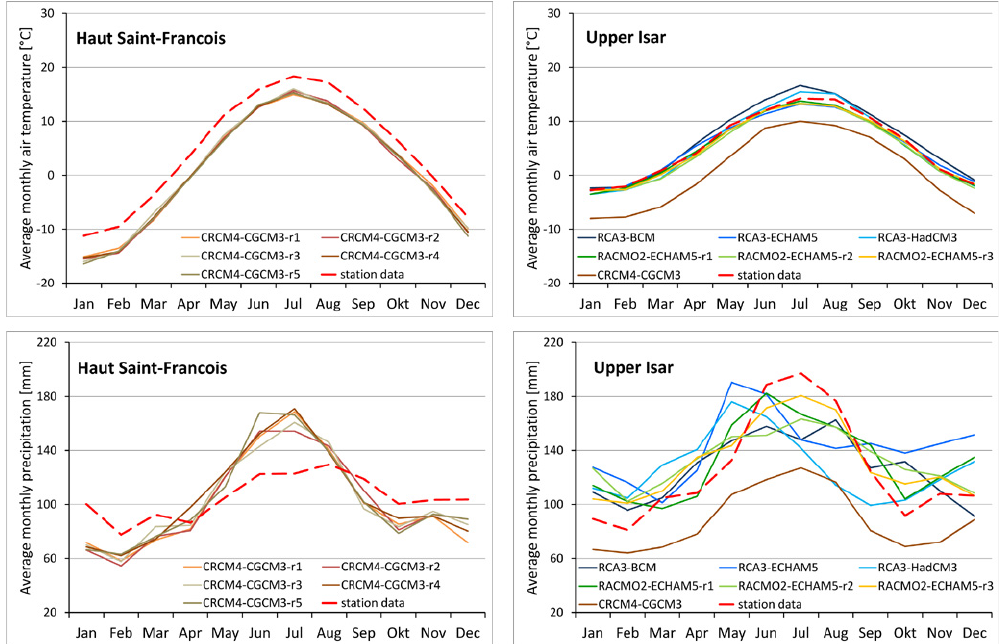
Fig. 3. Climatology of air temperature (upper panels) and precipitation (lower panels) over the main catchments Haut-Saint-Franc¸ois (left panels) and Upper Isar (right panels) derived from climate models and observations. (Acronyms refer to RCM–GCM combinations and runs in a GCM member